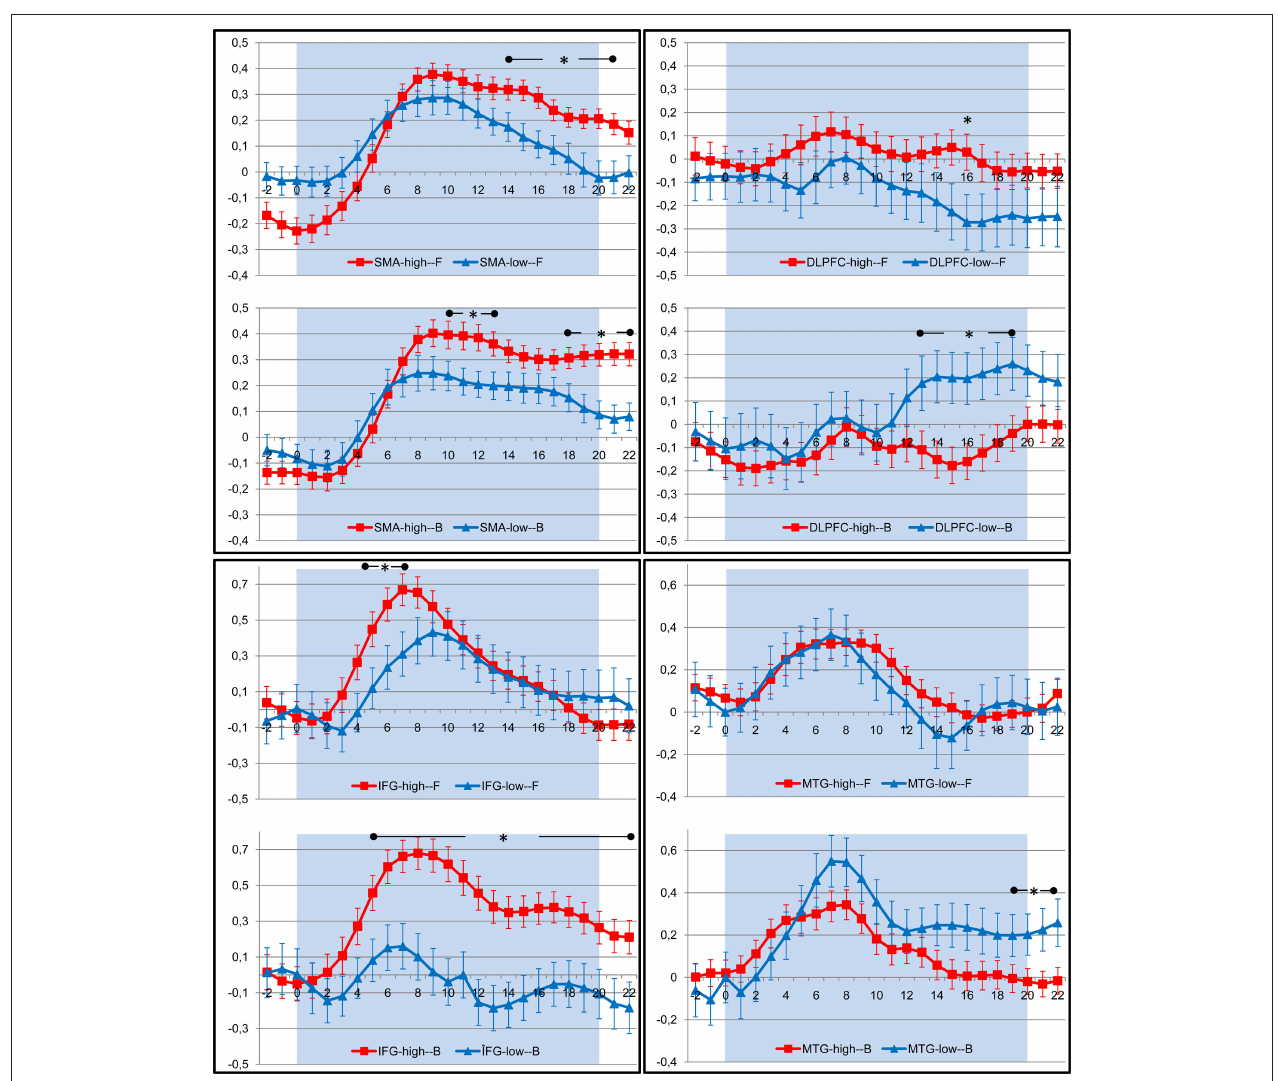
area indicates the period of imagination. SMA, supplementary motor area; DLPFC, dorsolateral prefrontal cortex; IFG, inferior frontal gyrus; MTG, middle temporal gyrus. Time points with significant differences between both groups are indicated by stars ( P < 0.05, Student’s t -test for independent